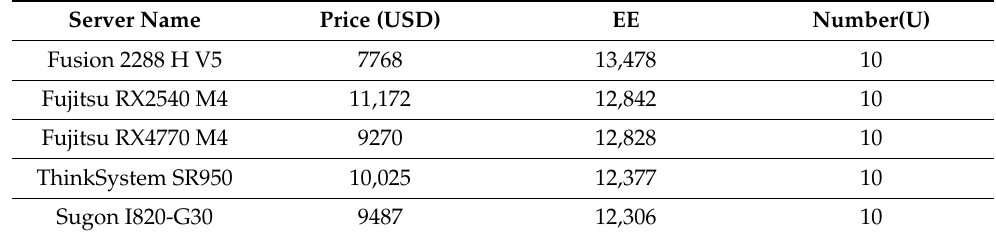
Table 4. Release year and number of servers under 1 × 10 10 throughput in data center #4.